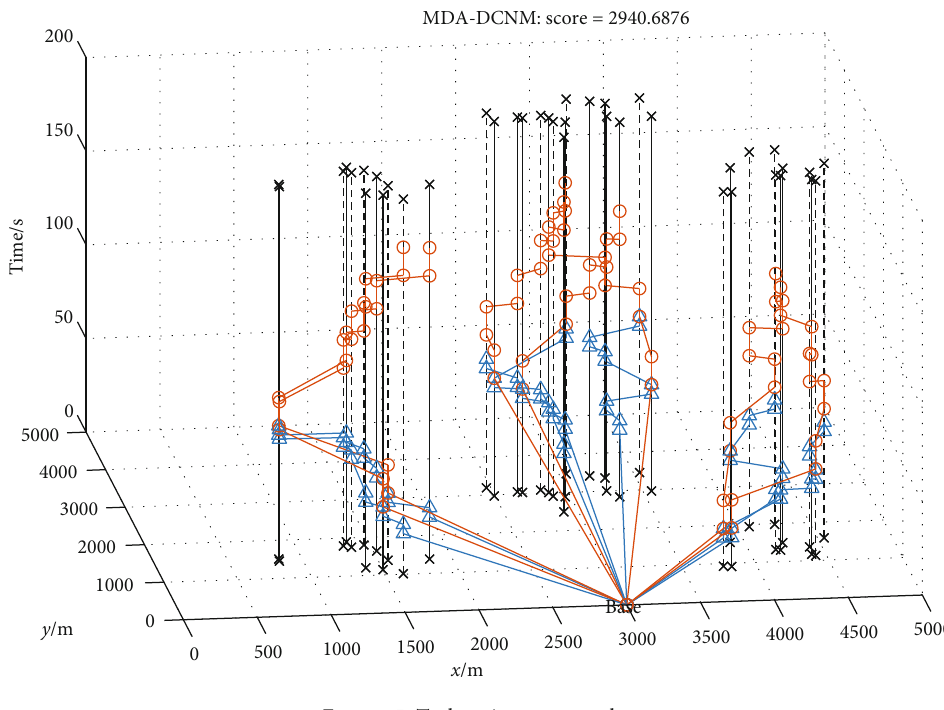
Figure 5: Task assignment